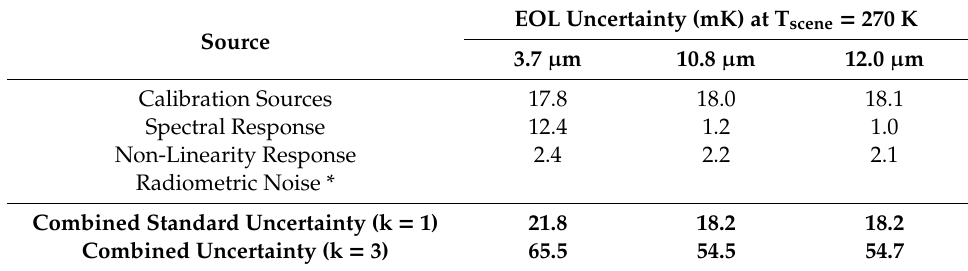
Table 2. Primary sources of uncertainty in radiometric calibration of SLSTR for a scene brightness temperature at 270 K at End of life. Uncertainties are reported at k = 1 and expressed in brightness temperature in